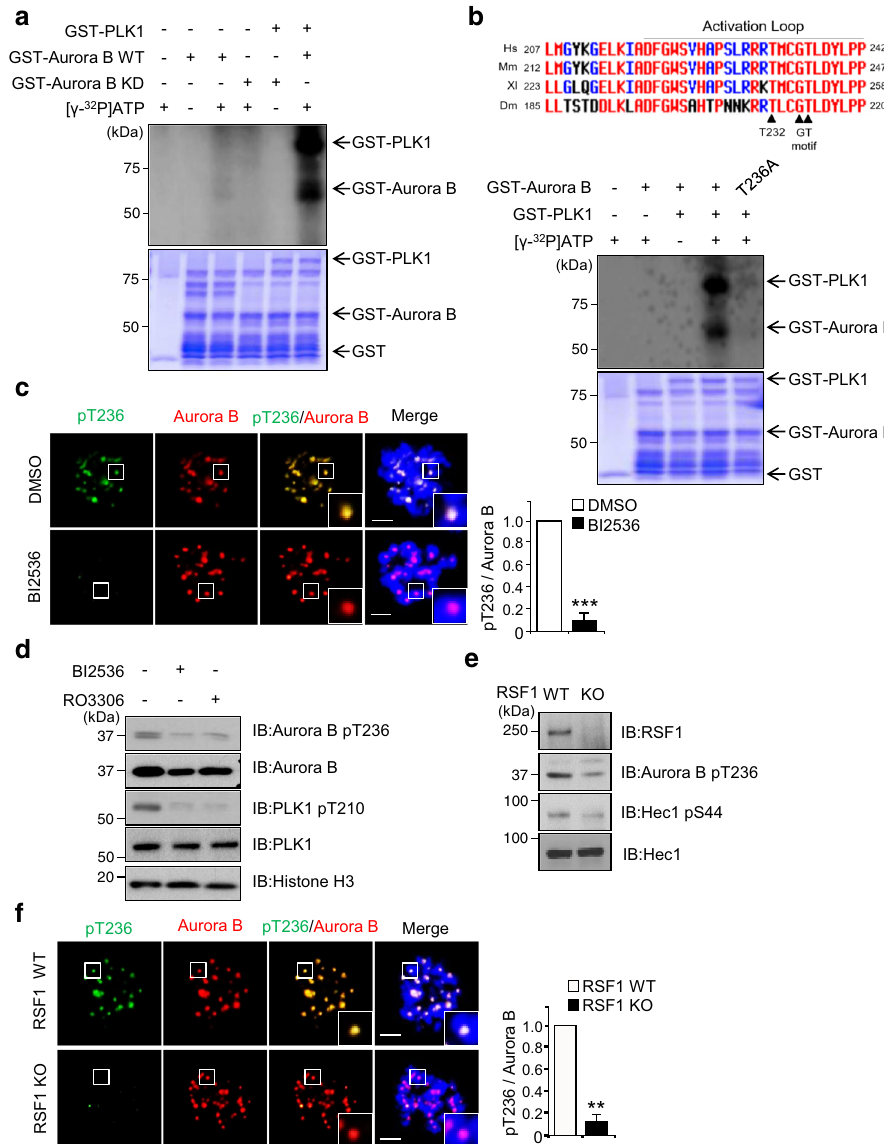
Fig. 3 Polo-like kinase 1 modulates Aurora B kinase activity via phosphorylation of GT motif. a In vitro kinase assay: recombinant GST-Aurora B WT or KD proteins puri fi ed in the bacteria was incubated with the active GST-PLK1 at 30 °C for 30 min in the presence of γ 32 P-ATP. Incorporation of γ 32 P into Aurora B protein was visualized by autoradiography. Coomassie blue staining demonstrates equal protein loading. b Alignment of vertebrate Aurora B sequence from humans to mouse across a short region with the conserved GT motif (upper panel). In vitro kinase assay of phosphorylation mutants on the GST-Aurora B were incubated with the active GST-PLK1 at 30 °C for 30 min in the presence of γ 32 P-ATP. c Synchronized mitotic HeLa cells were treated with the PLK1 inhibitor BI2536 or DMSO for 30 min. Cells were then fi xed and stained with anti-pThr236-Aurora B antibody (green), Aurora B (red), and DAPI (blue). Bars represent mean ± SEM from three independent experiments; DMSO n = 32, BI2536 n = 35 cells. *** p < 0.001 vs. DMSO by two-sided unpaired Student ’ s t -test. Scale bar, 5 μ m. d HeLa cells synchronized to mitosis by Nocodazole were pre-treated with MG132 for 1 h and with BI2536, Ro3306, or DMSO for 30 min, followed by western blot analysis with the indicated antibodies. e RSF WT or RSF1 KO HeLa cells were synchronized to mitosis by Nocodazole, followed by western blotting analyzed by the indicated antibodies. f RSF WT or RSF1 KO HeLa cells were treated with nocodazole for 4 h. Mitotic cells were fi xed with 4% paraformaldehyde and stained with anti-pT236-Aurora B (green) and anti-Aurora B (red) antibodies. Nucleus was stained with DAPI (blue). Bar represents mean ± SEM from three independent experiments; WT n = 27, RSF1 KO n = 44 cells. ** p < 0.005 vs. RSF1 WT by two-sided unpaired Student ’ s t -test. Scale bar, 5 μ m. Data of a , b , d , e are representative of three independent experiments. Source data are provided as a Source Data fi answer on how the phosphorylation on Thr236 affects the auto- catalytic activity of Aurora B kinase on the activation loop. The nucleophilic attack on the γ -phosphate of ATP, generating pThr232. autophosphorylation of Thr232 in Aurora B is the general base- As the activation loop harboring Thr232 and Thr236 is totally dis- catalyzed reaction (Supplementary Fig. 3) in which the side chain of ordered in the crystal structure of human Aurora B (PDB code: Asp200 serves as a catalytic base that mediates a nucleophilic attack, 4AF3) 37 , we exploited the crystal structure of Xenopus Aurora B which facilitates the transfer of the γ -phosphate to Thr236 40 . The (PDB code: 2BFX) 41 to speculate how the phosphorylation of